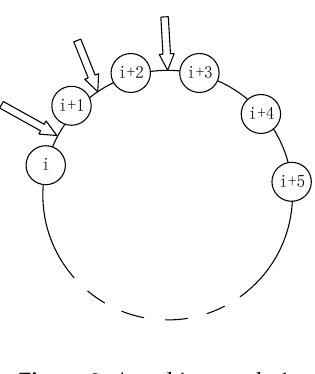
Figure 3. Attacking mode